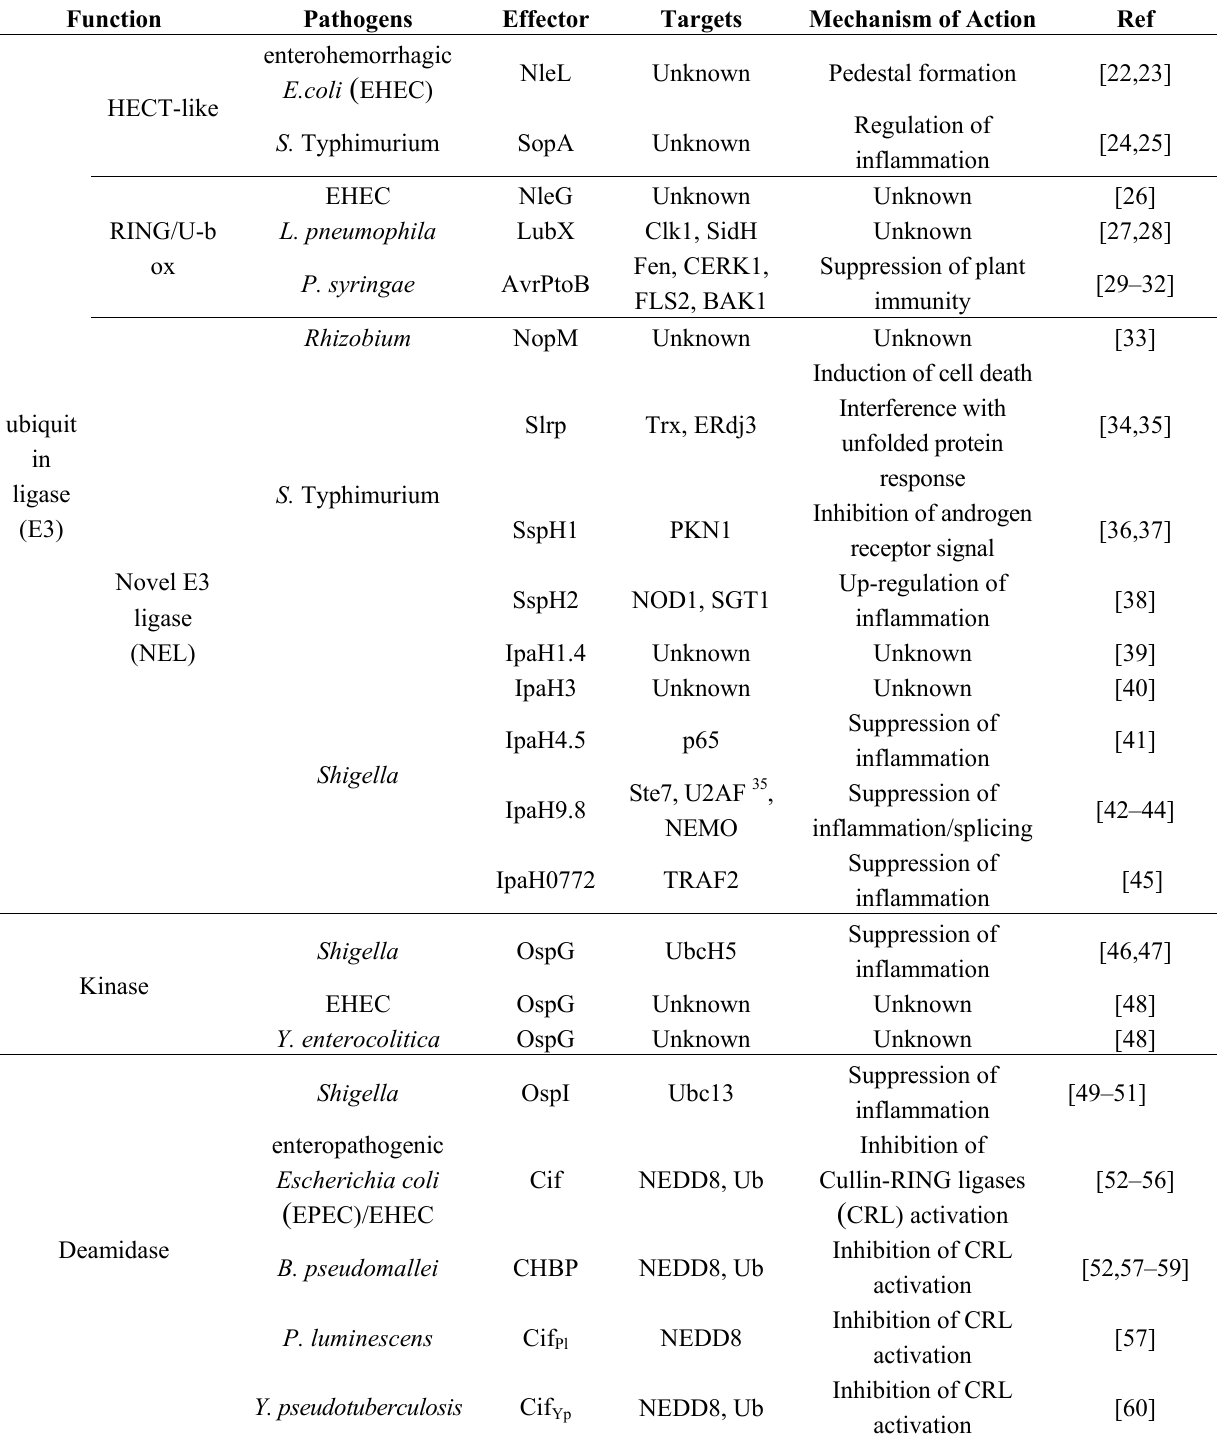
Table 1. Summary of protein post-translational modifications (PTM)-targeting bacterial effectors.